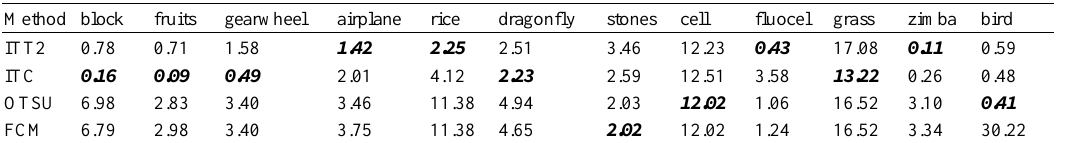
Table 5. Result of experiment